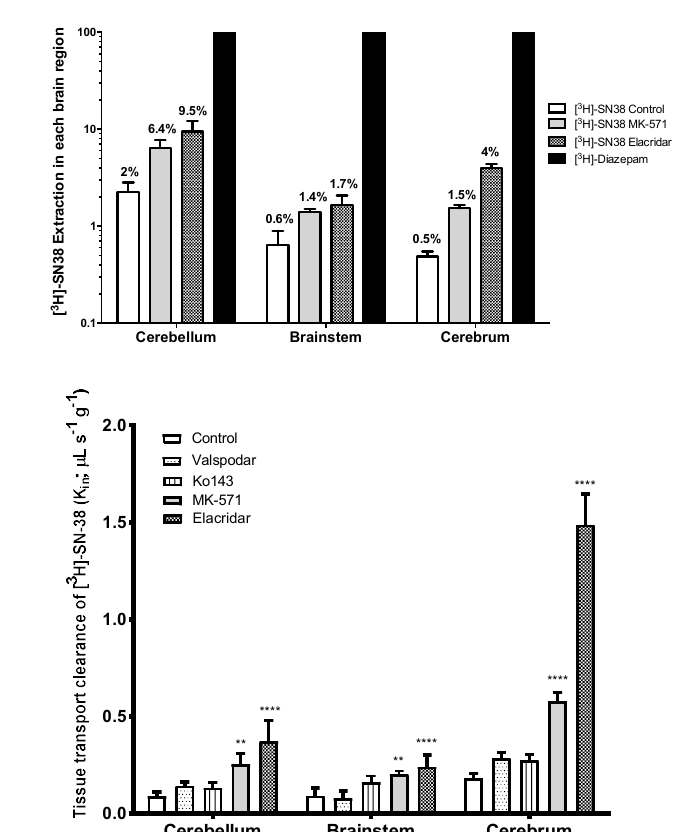
Figure 4. ( A ) Tissue extraction of [ 3 H]-SN-38 (E; %) expressed as the percent of [ 3 H]-diazepam brain transport (set to 100% in every analyzed region). Results are expressed as mean ± S.D. ( n = 5 rats per group). ( B ) Intrinsic tissue transport clearance (Kin; µL s −1 g −1 ) of [ 3 H]-SN-38 within the cerebellum, brainstem, and cerebrum, in the presence or absence of ABC transporter(s) inhibitor measured by in situ brain perfusion in 8-week-old RH-Foxn1rnu nude rats. Results are expressed as mean ± S.D. ( n = 5 animals per group). One-way ANOVA, ** p < 0.01; **** p < 0.0001 vs. control group.